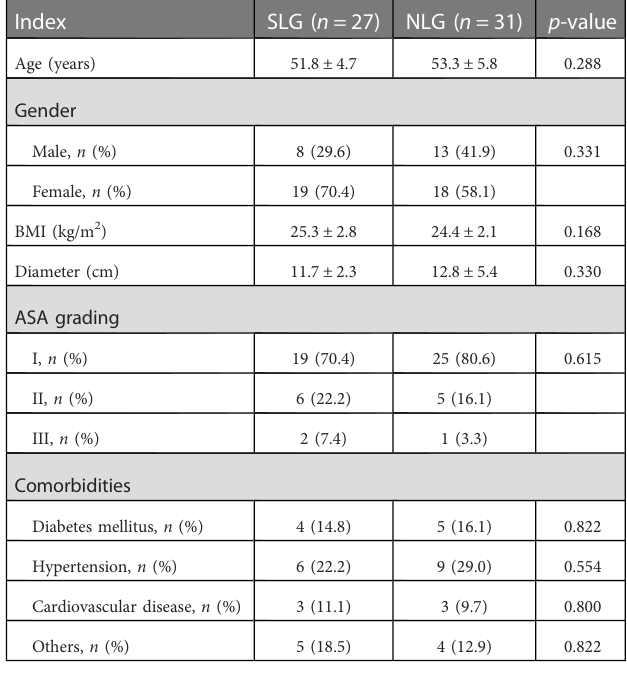
TABLE 1 General data of